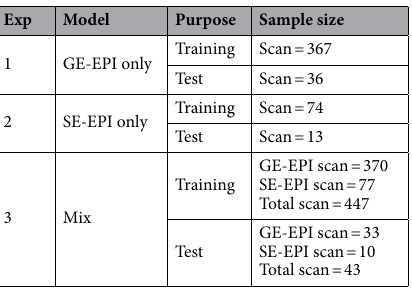
Table 3. Summary of the combinations of datasets used in three